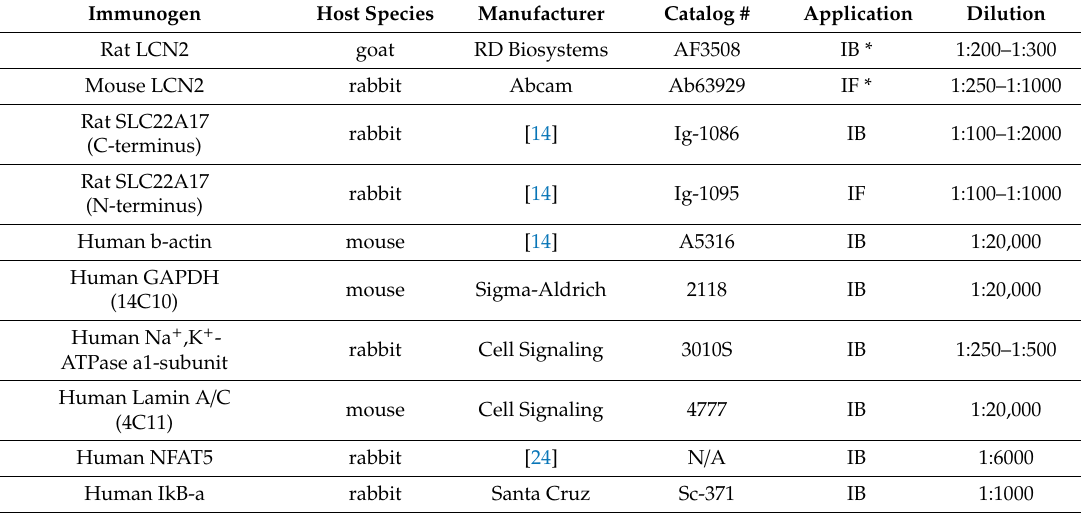
Table 1. Primary